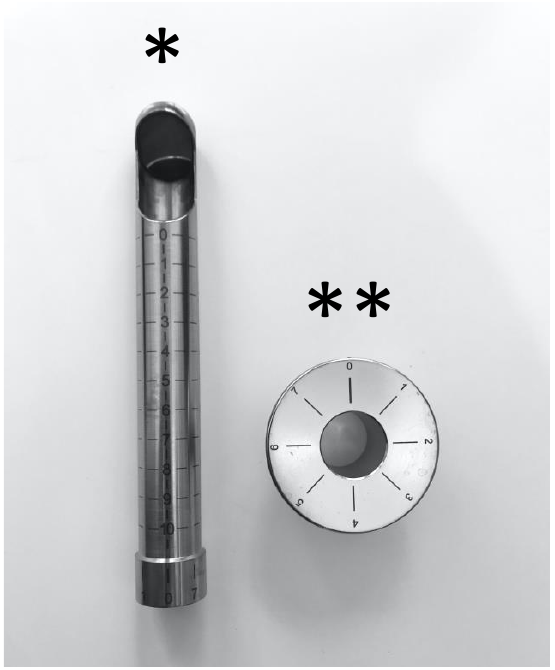
Figure 1. The figure represents the vaginal device of the laser. * Vaginal probe, ** graduated guide.